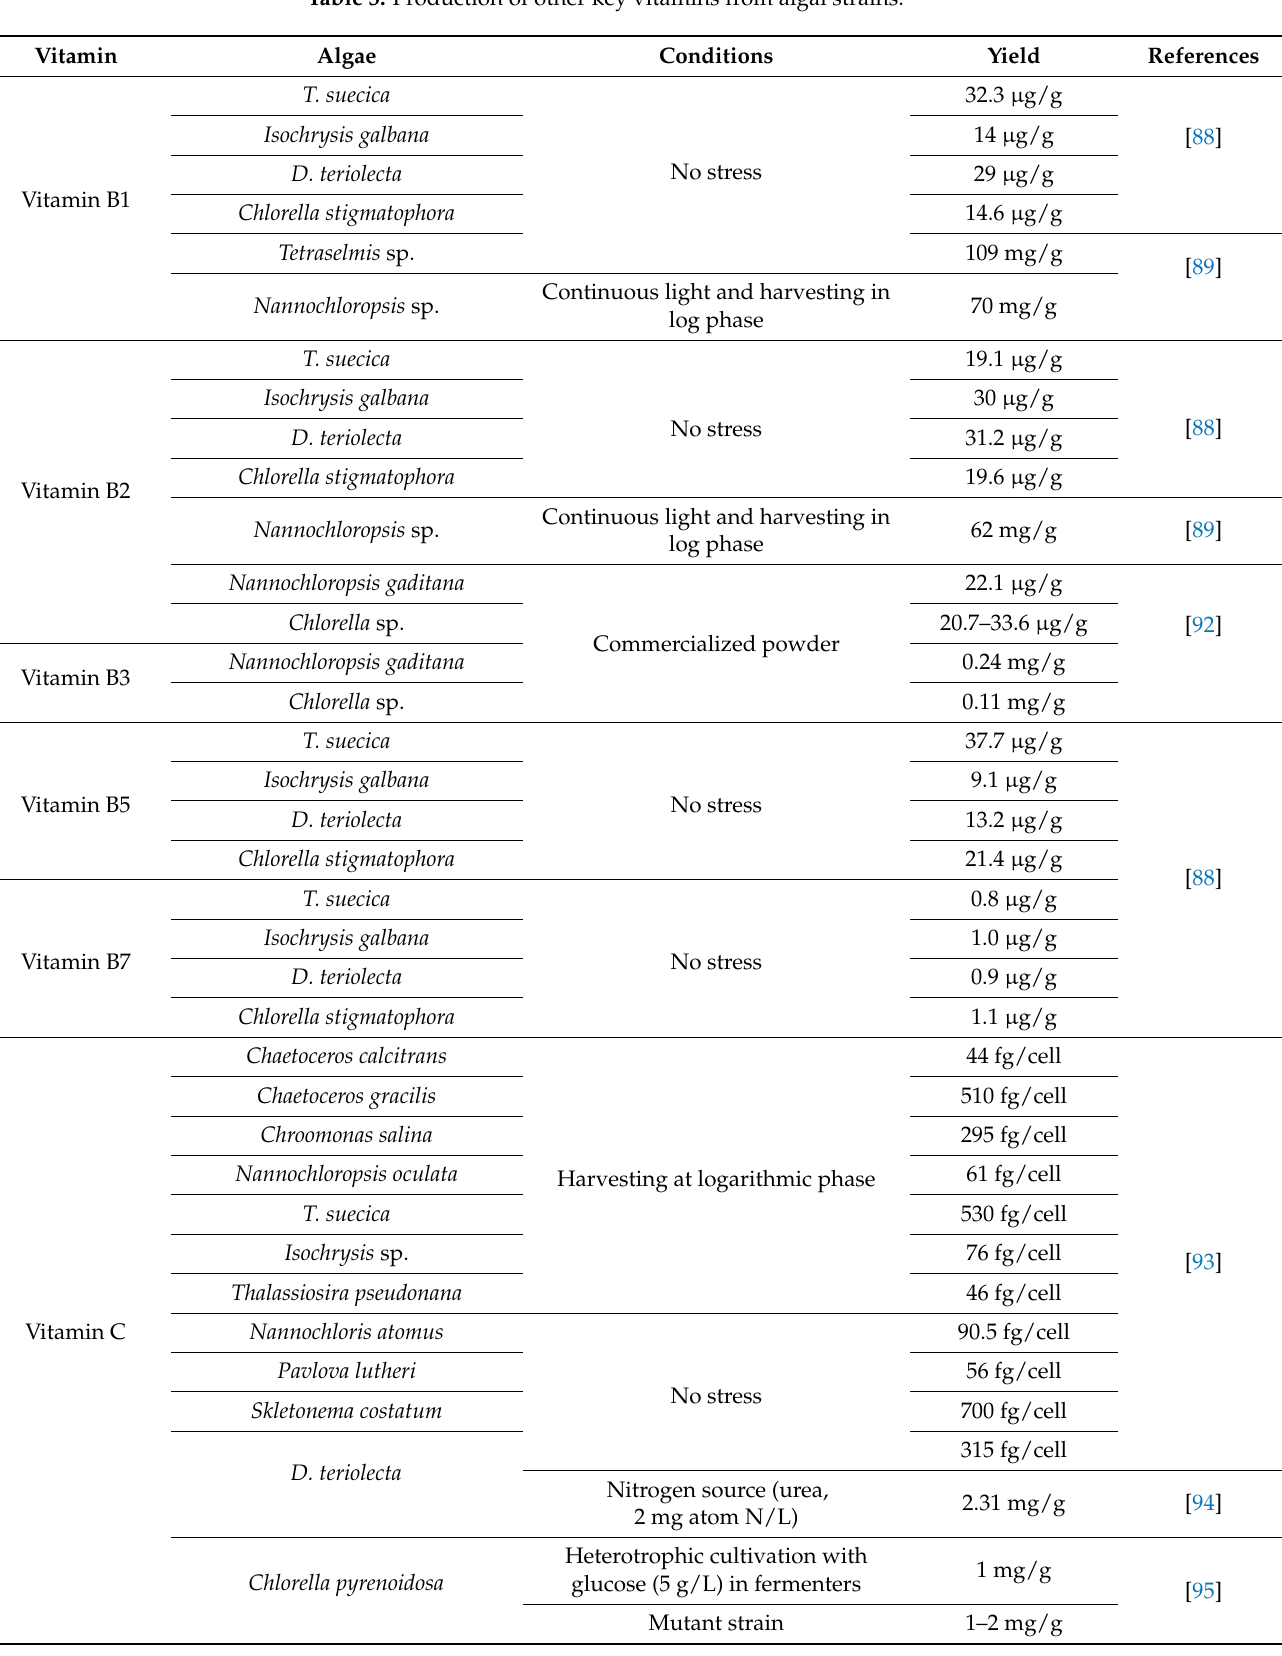
Table 3. Production of other key vitamins from algal